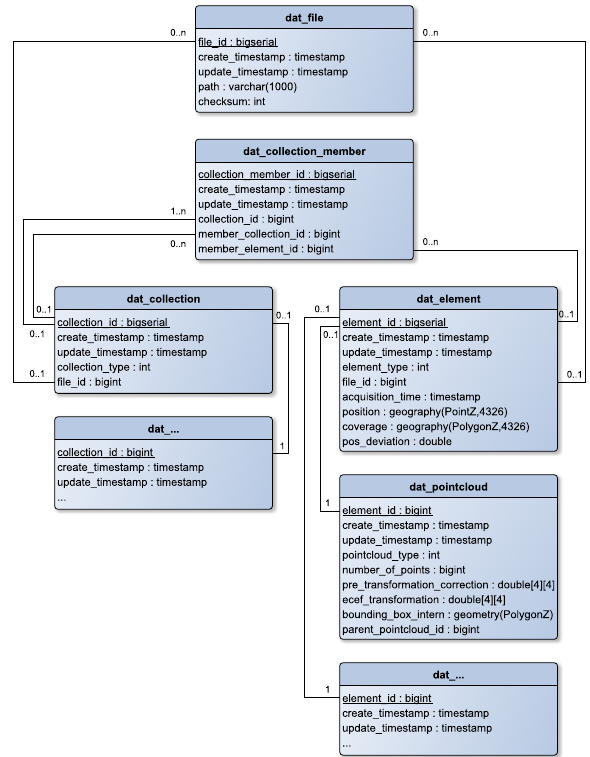
Figure 1. Simplified ER diagram of our